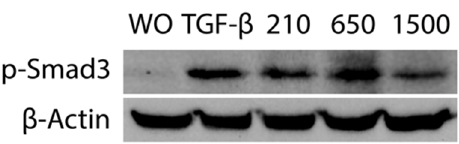
Figure 5. PRF lysates prepared at different g -forces activated phosphorylation of Smad3. Gingival fibroblasts were exposed to 30% of the PRF lysates prepared at 210 g , 650 g and 1500 g overnight. Western blot showed a strong increase of the basal Smad3 phosphorylation signal by all the PRF lysates. This Western blot is representative for three independent experiments.